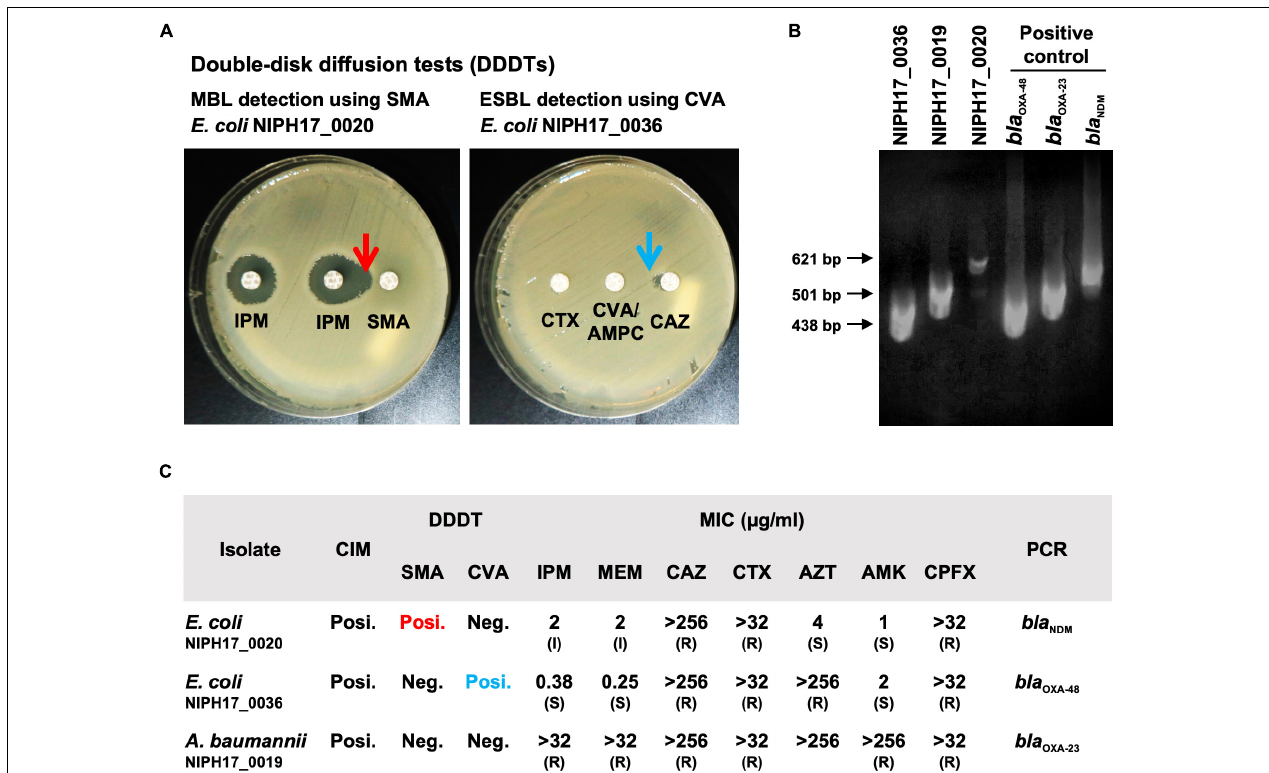
FIGURE 2 | Genotype and phenotype analysis of AMR bacteria isolated in Cambodia. (A) The double-disk diffusion test (DDDT) with imipenem (IPM) and sodium mercaptoacetic acid (SMA) disks against E. coli NIPH17_0020 for MBL detection and DDDT with ceftazidime (CAZ), cefotaxime (CTX), and clavulanate/amoxicillin (CVA/AMPC) disks against E. coli NIPH17_0036 for ESBL detection. Arrows indicate β -lactamase inhibition. (B) PCR amplifications for bla OXA − 48 for E. coli NIPH17_0036 (438 bp), bla OXA − 23 for A. baumannii NIPH17_0019 (501 bp), bla NDM for E. coli NIPH17_0020 (621 bp) and their positive controls. Some of the images are unclear because they were acquired in a location with limited equipment. (C) Summary of genotype and phenotype analysis, including the carbapenem inactivation method (CIM), DDDTs with SMA or CVA, minimum inhibitory concentrations (MIC) measurement, and PCR targeting selected major carbapenemase genes. The breakpoints for susceptible (S), intermediate (I), and resistance (R) to antimicrobials were adopted from the CLSI 2020 guidelines.